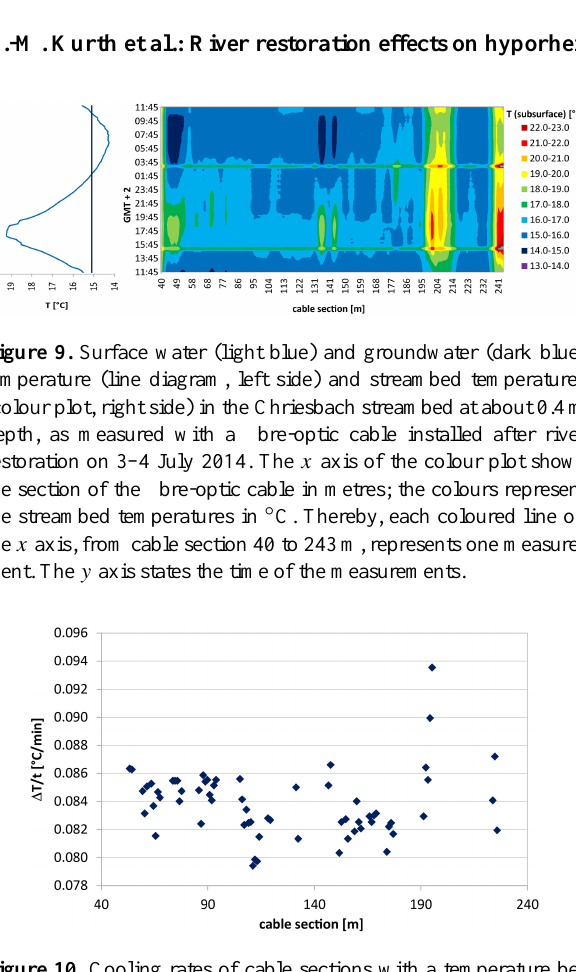
Figure 10. Cooling rates of cable sections with a temperature be- tween 15.9 and 16.1 ◦ C determined at night in ◦ Cmin − 1